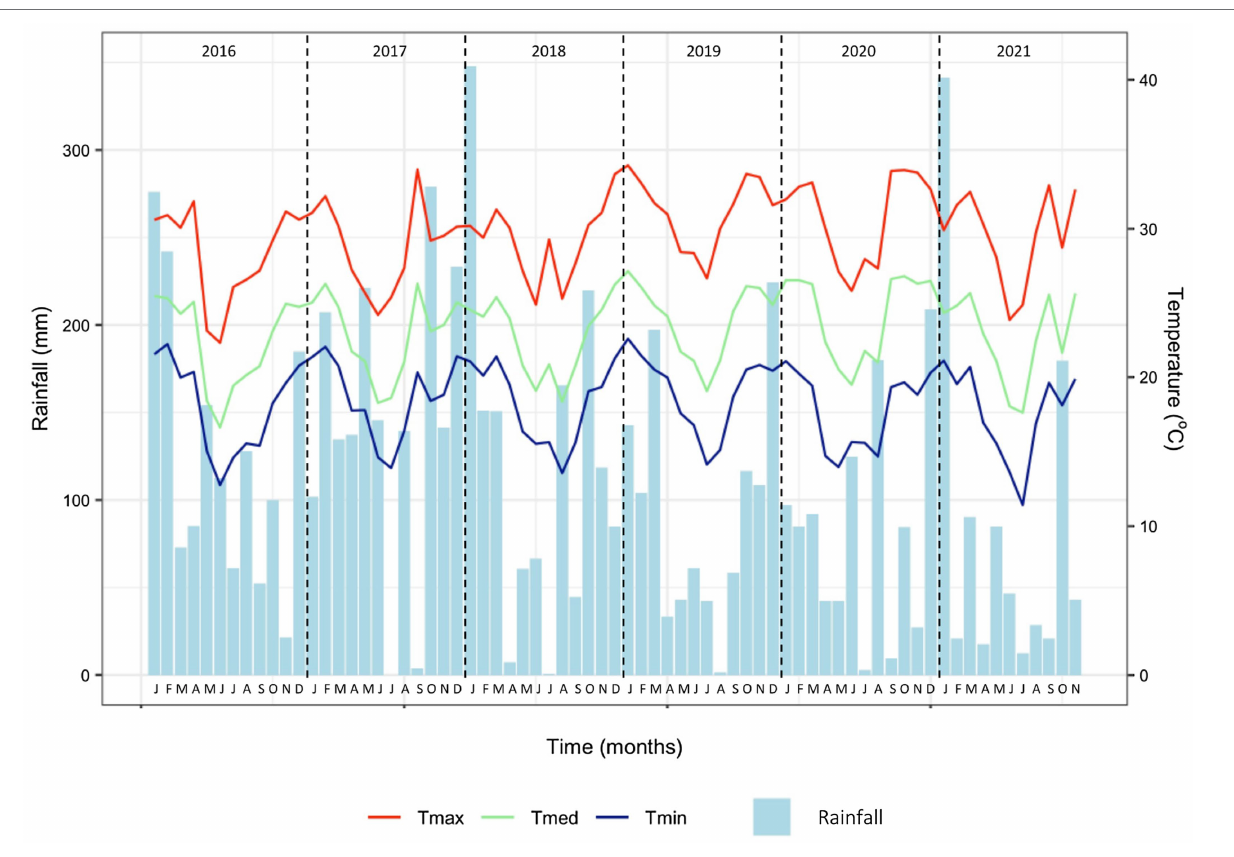
FIGURE 1 | Monthly rainfall and maximum (Tmax), medium (Tmed) and minimum (Tmin) average temperatures from 2016 to 2021 in Guairaçá, state of Paraná, Brazil (Source: IDR–Paraná,